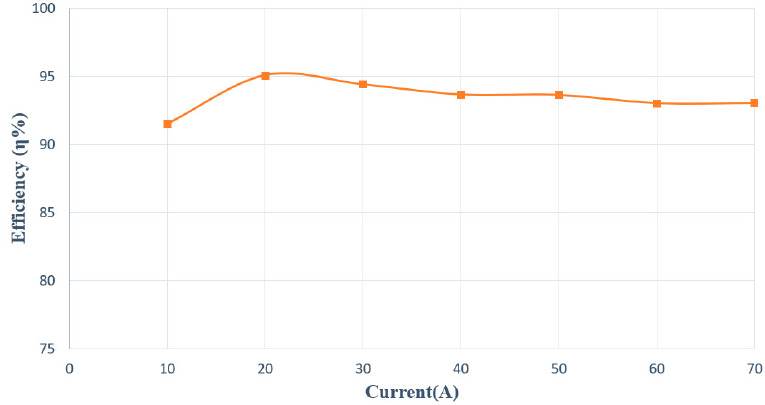
Figure 13. Efficiency curve of three phases interleaved system.